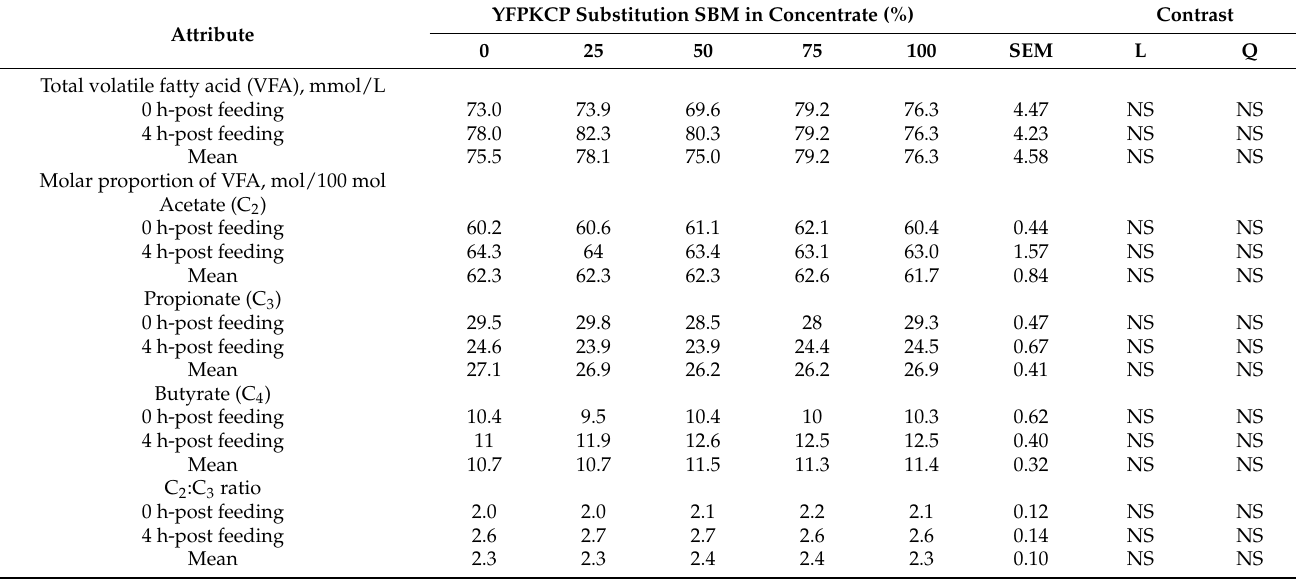
Table 5. Effects of fermented palm kernel cake on volatile fatty acid (VFA) profiles in goats fed on plicatulum hay as